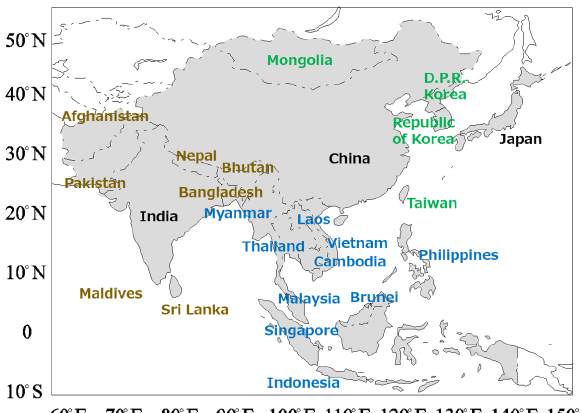
Figure 1. Domain and target countries of REASv3. In this paper, countries written in blue, green, and brown characters were defined as SEA (Southeast Asia), OEA (East Asia other than China and Japan), and OSA (South Asia other than India),